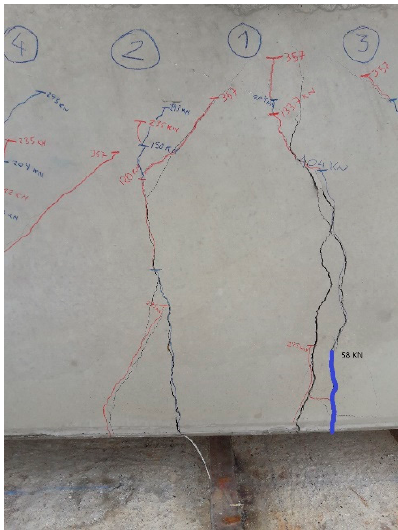
Figure 12. Visual inspection of cracks on the 300 × 500 mm beam.